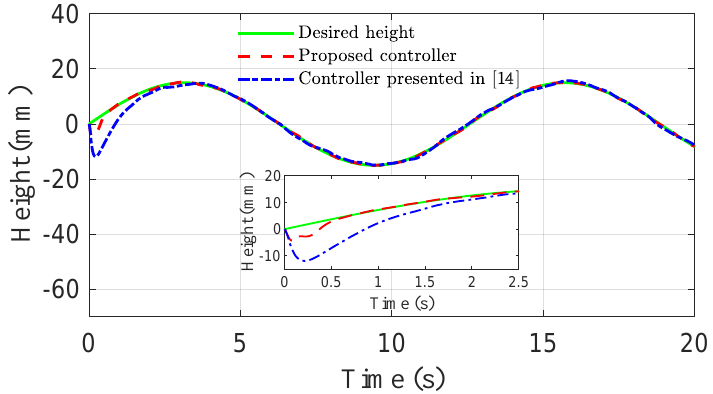
Figure 9. Height comparison of quarter vehicle with AAS in